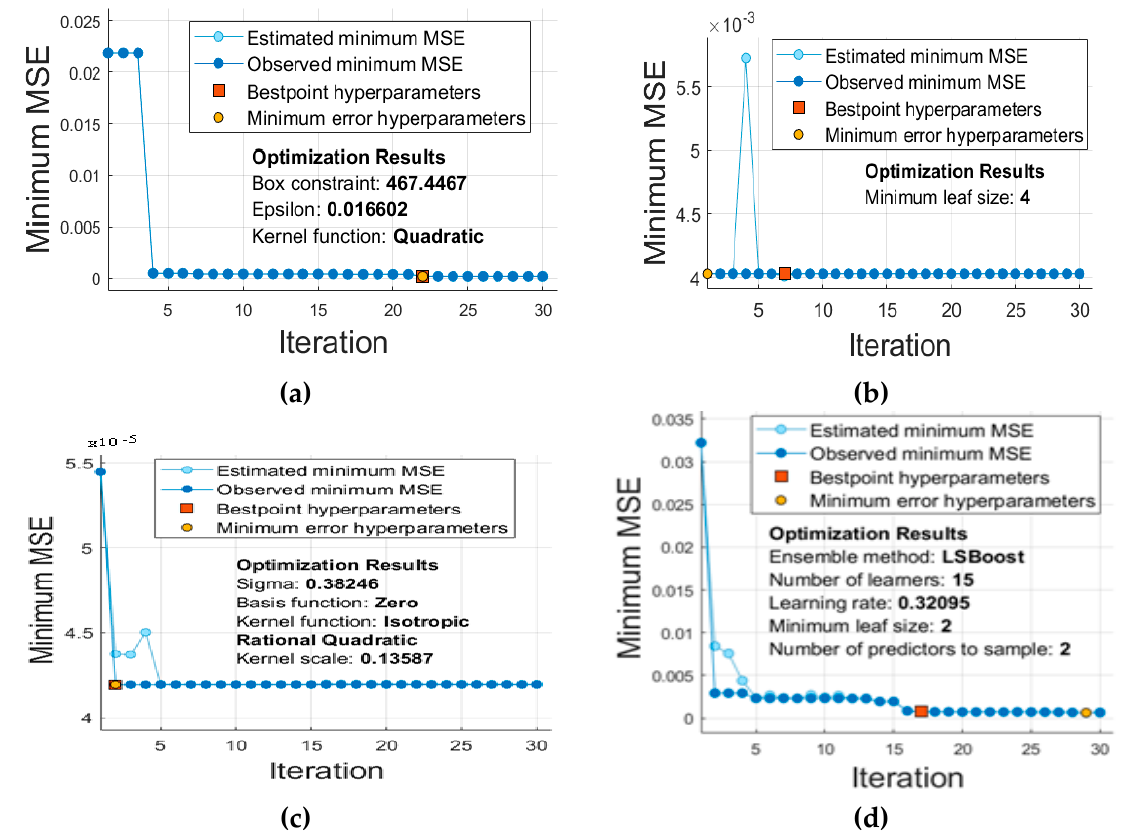
Figure 9. Minimum mean squared error (MSE) for the various regression learner optimizable models: ( a ) Optimizable SVM, ( b ) Optimizable Tree, ( c ) Optimizable GPR, ( d ) Optimizable Ensemble.